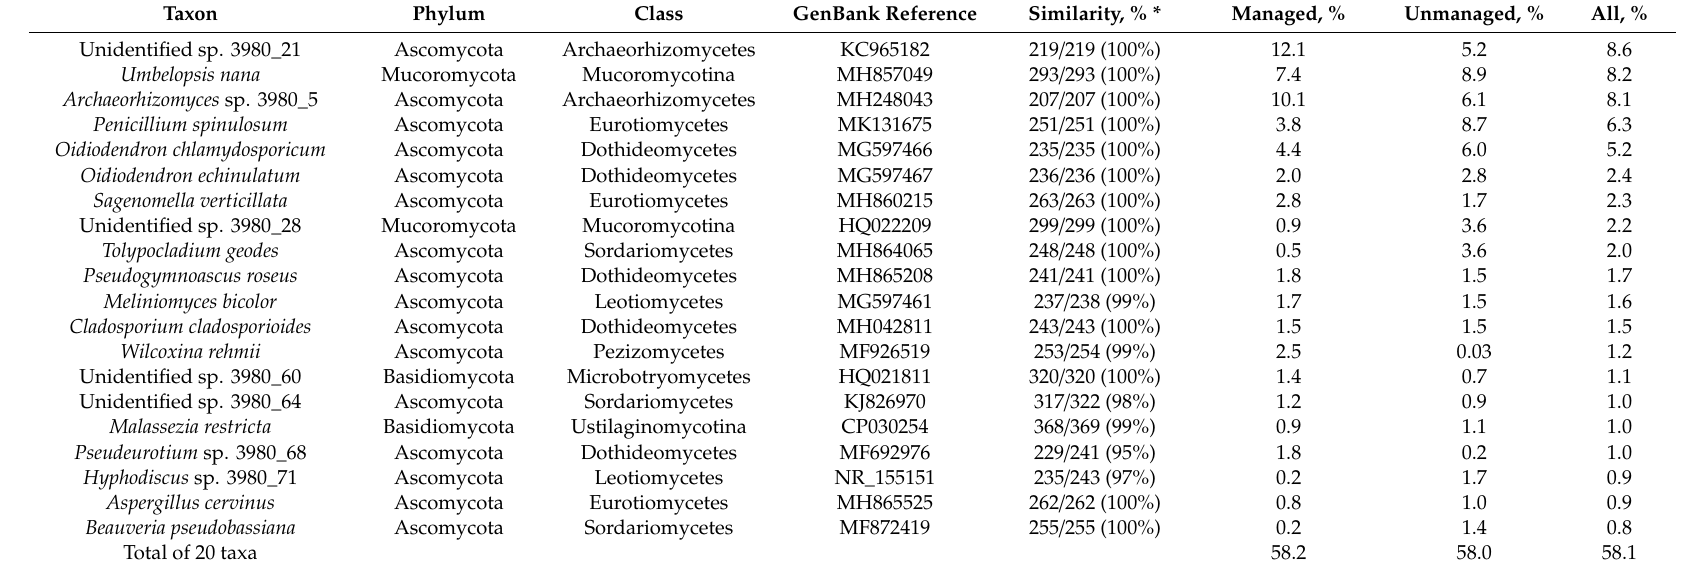
* Similarity column shows base pairs compared between the query sequence and the reference sequence at NCBI databases, and the percentage of sequence similarity in the